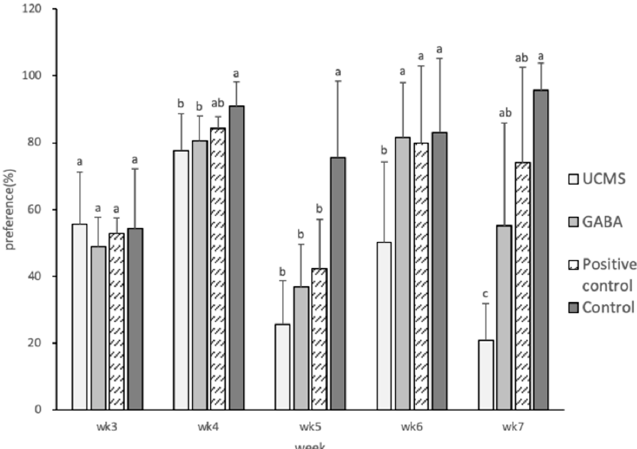
Figure 2. Effect of GABA feed made by vegetable soybean on sucrose preference in mice. Data are represented as mean ± SD. Group with different letter superscripts are significantly different ( p < 0.05).